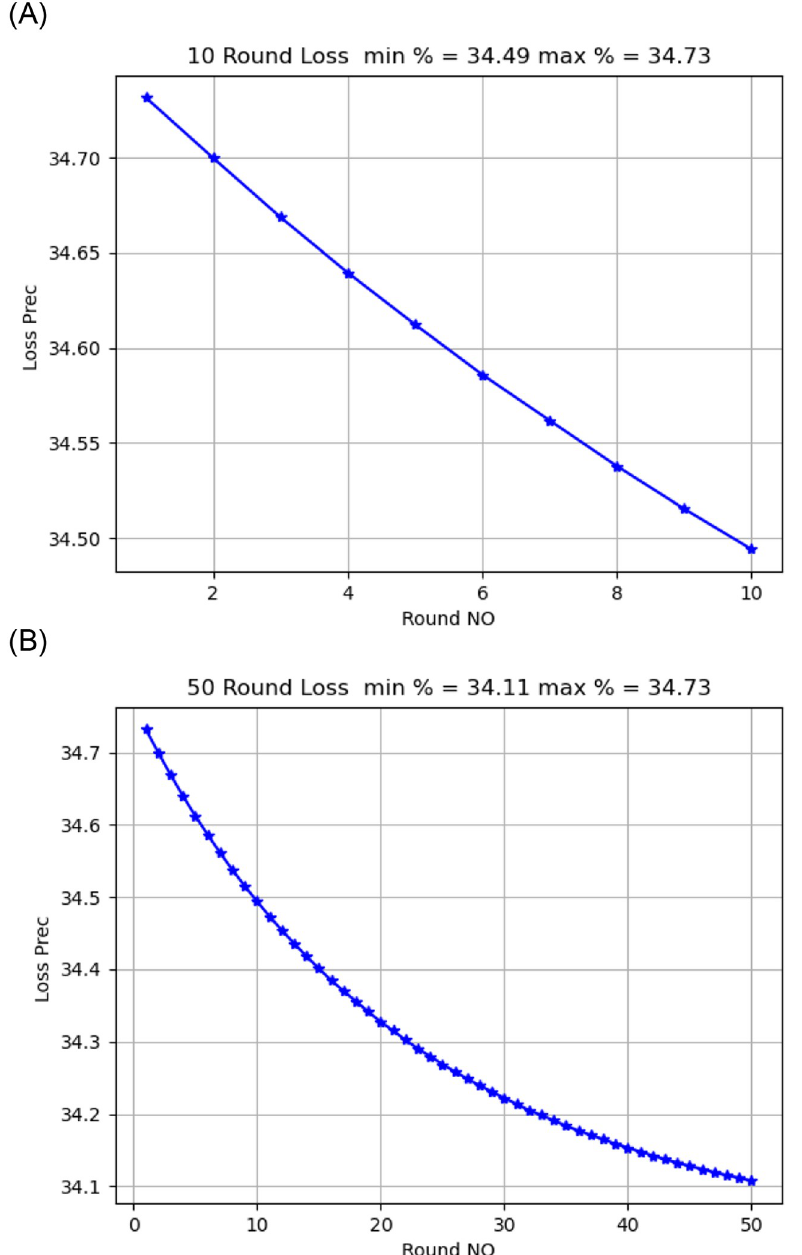
Fig 11. Model loss comparison for 10, 50